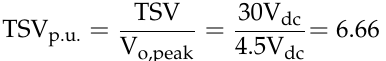
Figure 2. All positive conduction states.